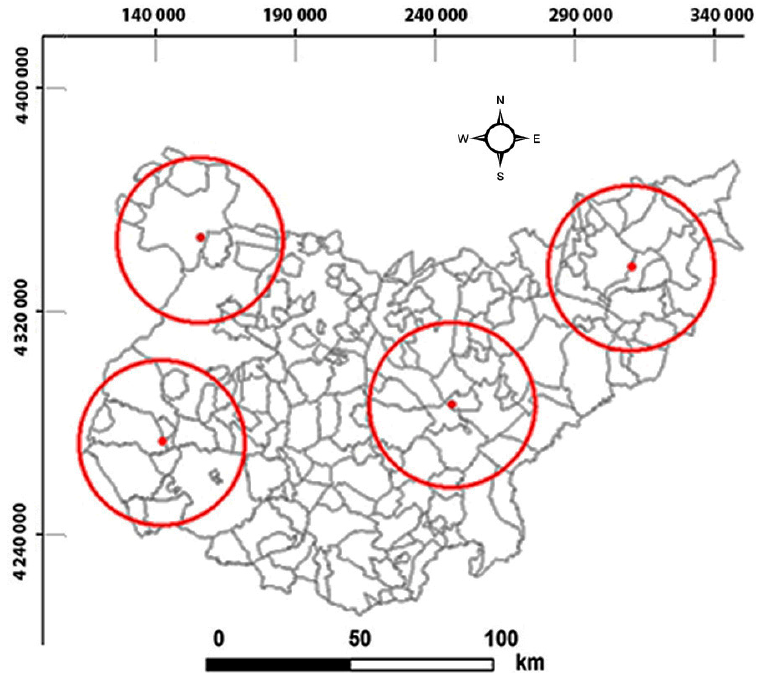
Figure 9. Ideal location of forest biomass storage centers.